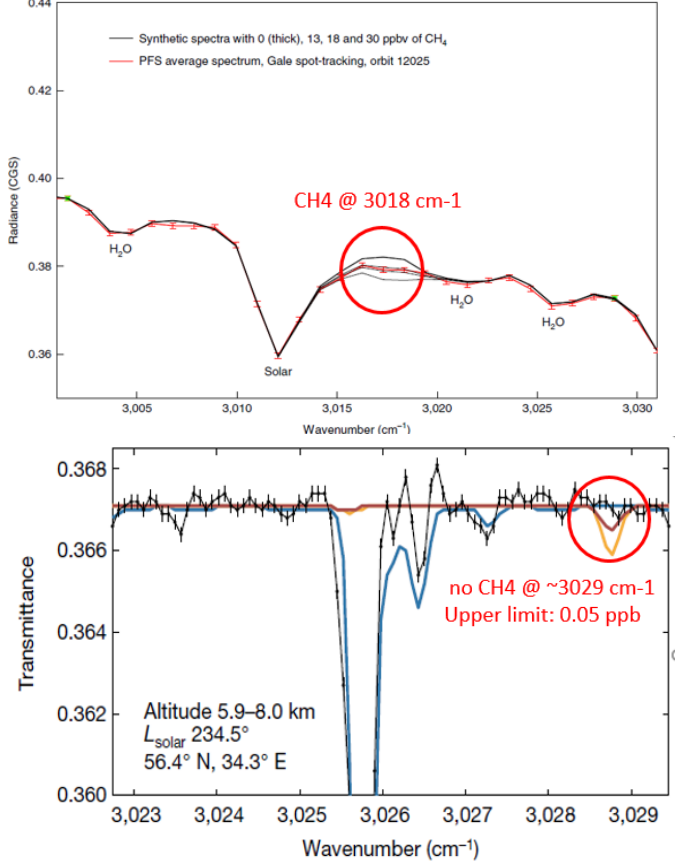
Figure 3. Positive and non-detection of methane on Mars by the MEx and ExoMars space probes, respec- tively. ( Top panel ) Measured integrated radiance spectrum, in cgs units (erg s − 1 cm − 2 sr − 1 ( cm − 1 ) − 1 ), taken by the PFS instrument on MEx, showing a methane absorption feature at approximately 3018 cm − 1 , by summing hundreds of spectra (image credits: Giuranna et al. [25]). ( Bottom panel ) Transmittance spectrum measured by the ExoMars TGO NOMAD SO instrument during the dust storm. An upper limit of 0.05 ppb of methane was estimated [26]. Data—black; blue—synthetic model with 1 ppm of H 2 O and no methane; yellow—synthetic model with 0.5 ppb of methane; red—synthetic model with 0.05 ppb of methane (image credits: Korablev et al.